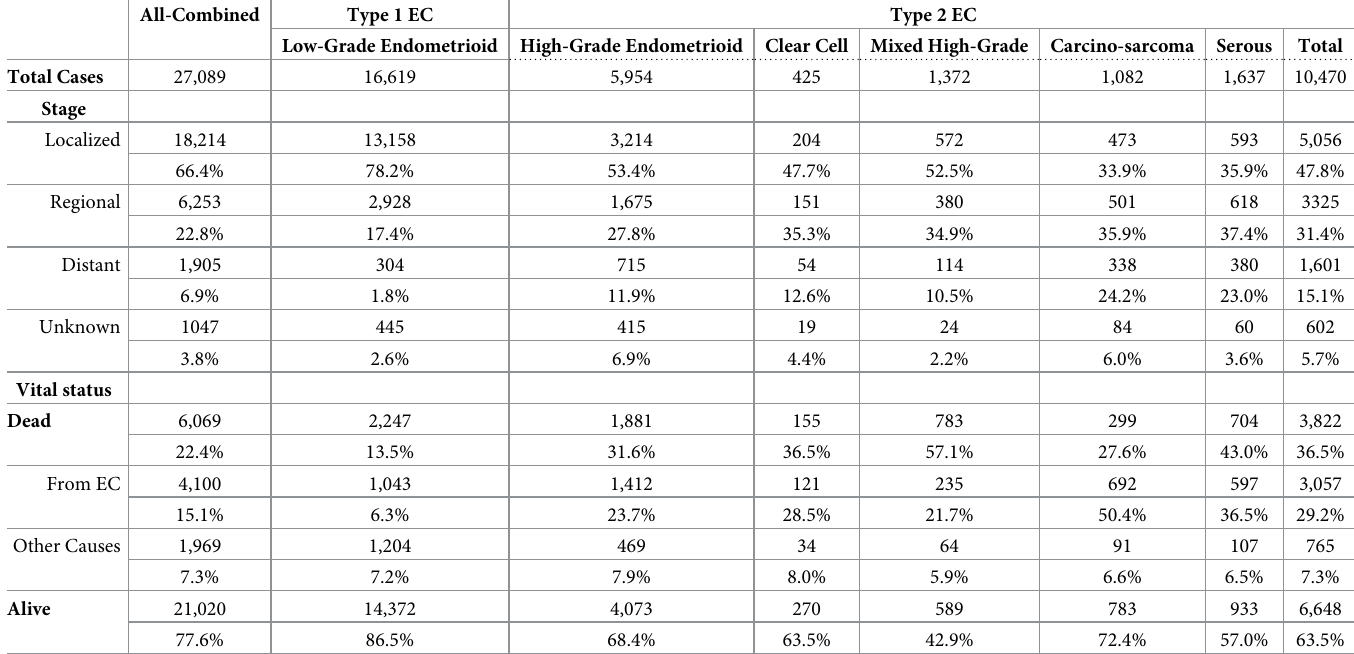
Table 2. Distribution (N and %) of stage at diagnosis and vital status/cause of death by histological type and subtype. Florida 2005–2016. All-Combined